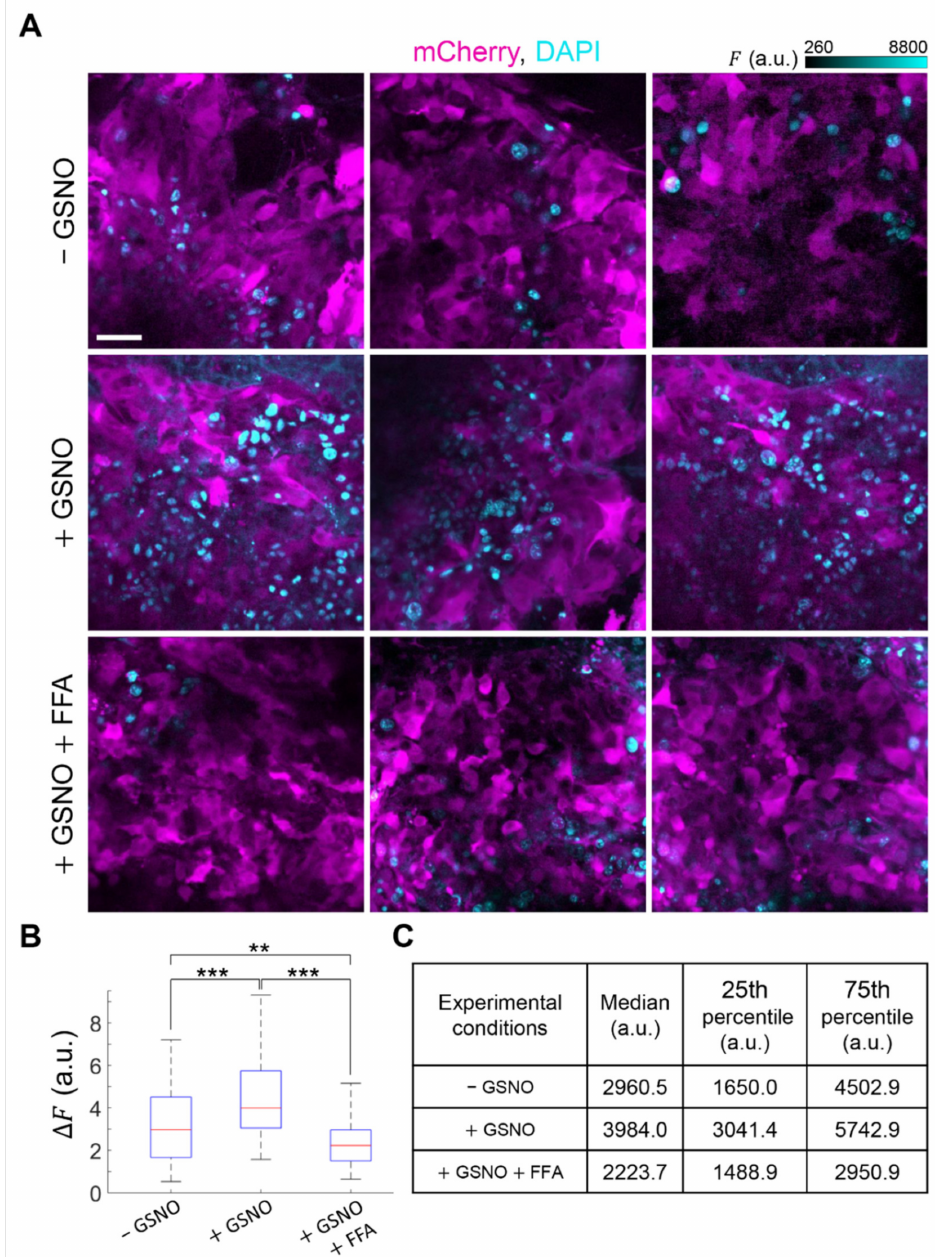
Figure 5. In vivo 4 (cid:48) ,6-Diamidine-2 (cid:48) -phenylindole dihydrochloride (DAPI) uptake assays. ( A ) Representative fluorescence intensity ( F ) images of mCherry-expressing melanomas acquired approximately 50 µ m below tumor surface after 30 min of incubation with DAPI (5 µ M) dissolved in: normal extracellular medium (NEM, control conditions: − GSNO); NEM contain- ing 1 mM of S-Nitrosoglutathione (+GSNO); NEM containing 1 mM of GSNO plus 100 µ M of flufenamic acid (+GSNO +FFA); scale bar: 20 µ m; a.u., arbitrary units; ( B ) Box plots showing the distributions of ∆ F = F (30 min) − F 0 ( F 0 = F before DAPI incubation) for DAPI fluorescence intensity measured in n ≥ 74 nuclei in − GSNO (3 tumors), +GSNO (3 tumors) or +GSNO +FFA (2 tumors) conditions; red horizontal bars represent the median; bottom and top edges of the blue boxes indicate the 25th and 75th percentiles, respectively; black tails of the boxes mark the most extreme data points in the distribution. **, p < 0.01; ***, p < 0.001, the Mann-Whitney U test; ( C ) Numerical values of median and quartiles for the three data